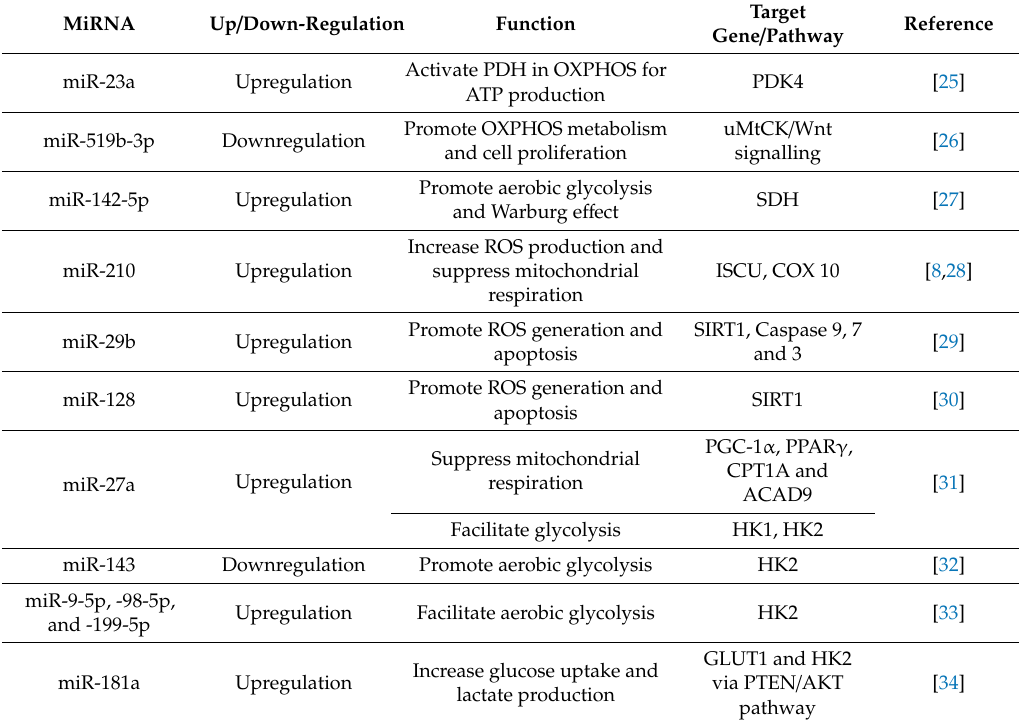
Table 1. The list of miRNAs involved in metabolic reprogramming of colorectal cancer (CRC). MiRNA Up / Down-Regulation